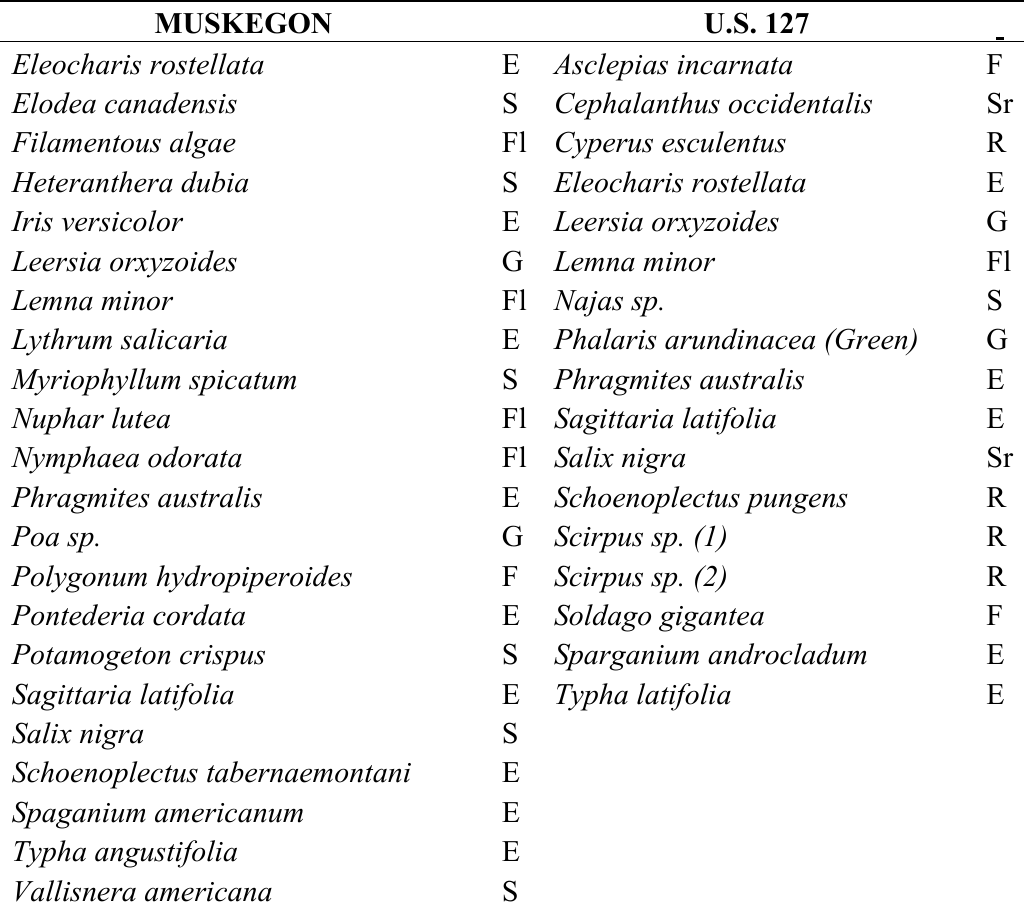
Table 1. Sampled species from each study area. E:Emergent, S:Submergent, Fl:Floating, G:Graminoin, F:Forb, Sr:Shrub,